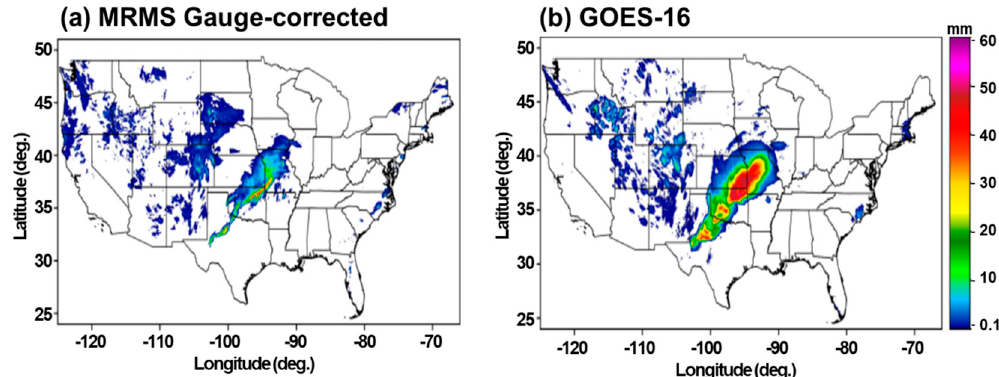
Figure 3. The comparison of hourly precipitation estimates from: ( a ) GC-MRMS; and ( b ) interpolated GOES-16 QPE for 0200–0300 UTC on 21 May 2019.